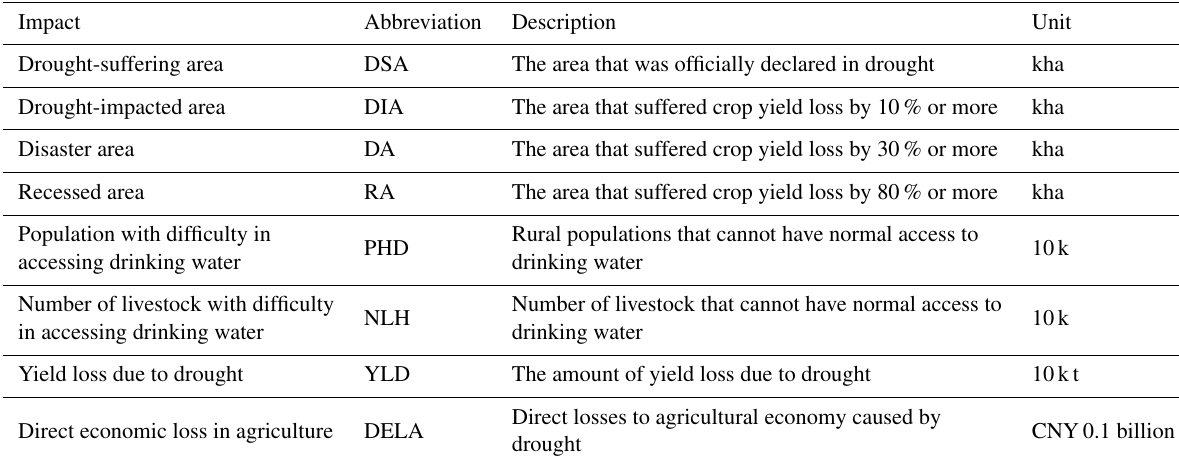
Table 1. The eight drought impact categories for Liaoning province used in this study collected by the SFDH. Impact